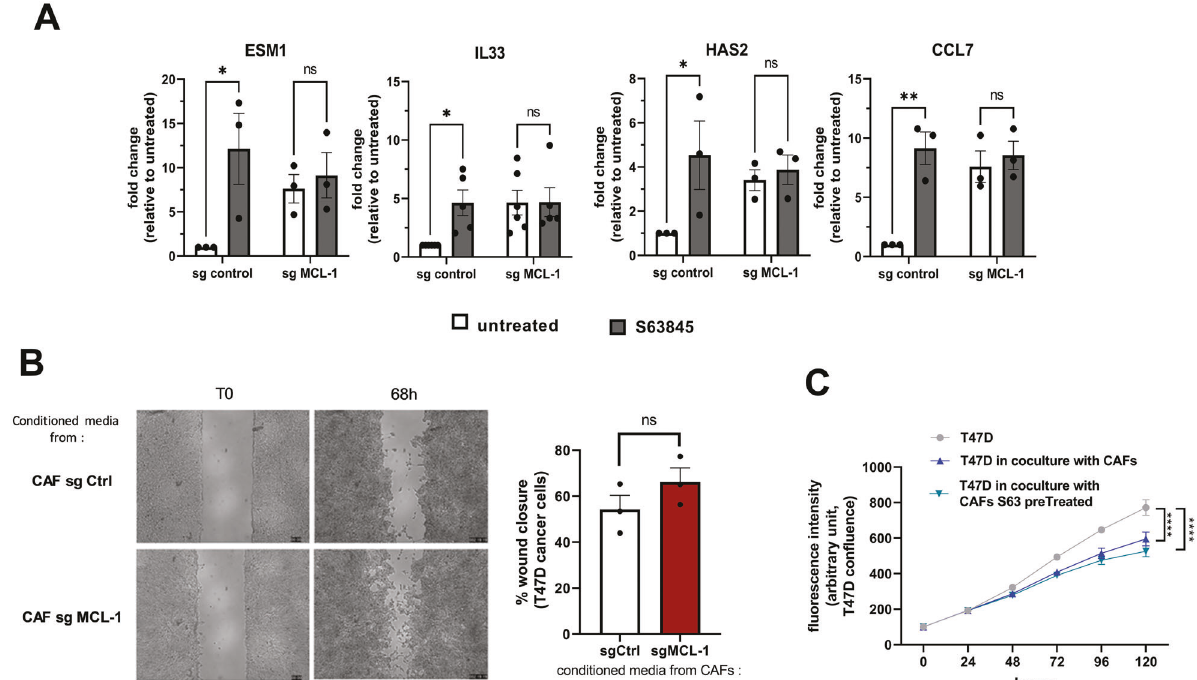
Fig. 4 MCL-1 targeting in bCAFs does not induce cancer cell migration or proliferation. A qRT-PCR of ESM1, IL33, HAS2 and CCL7 mRNA in CAFs Sg control or sg MCL-1 treated or not by S63845 500 nM for 18 h. Mean and SEM of three to fi ve independent experiments are represented as fold-change of mRNA level related to untreated Sg control. Two-way ANOVA, * P < 0.1, ** P < 0.01, ns: not signi fi cant. B (Left) Representative images from in vitro scratch wound-healing assays of T47D cancer cells in presence of conditioned media from CAFs Sg control or CAFs Sg MCL-1 at T0 and after 68 h. (Right) Quanti fi cation of wound closure expressed in percentage of total wound recovery at indicated time points during the scratch wound assay. Student t -test (ns: not signi fi cant). C Proliferation of T47D-eGFP cancer cells in coculture with CAFs pretreated or not with S63845 measured. Con fl uency was measured using time-lapse video-microscopy (incucyte live cells analysis) during 120 h. Student t- test (**** P <